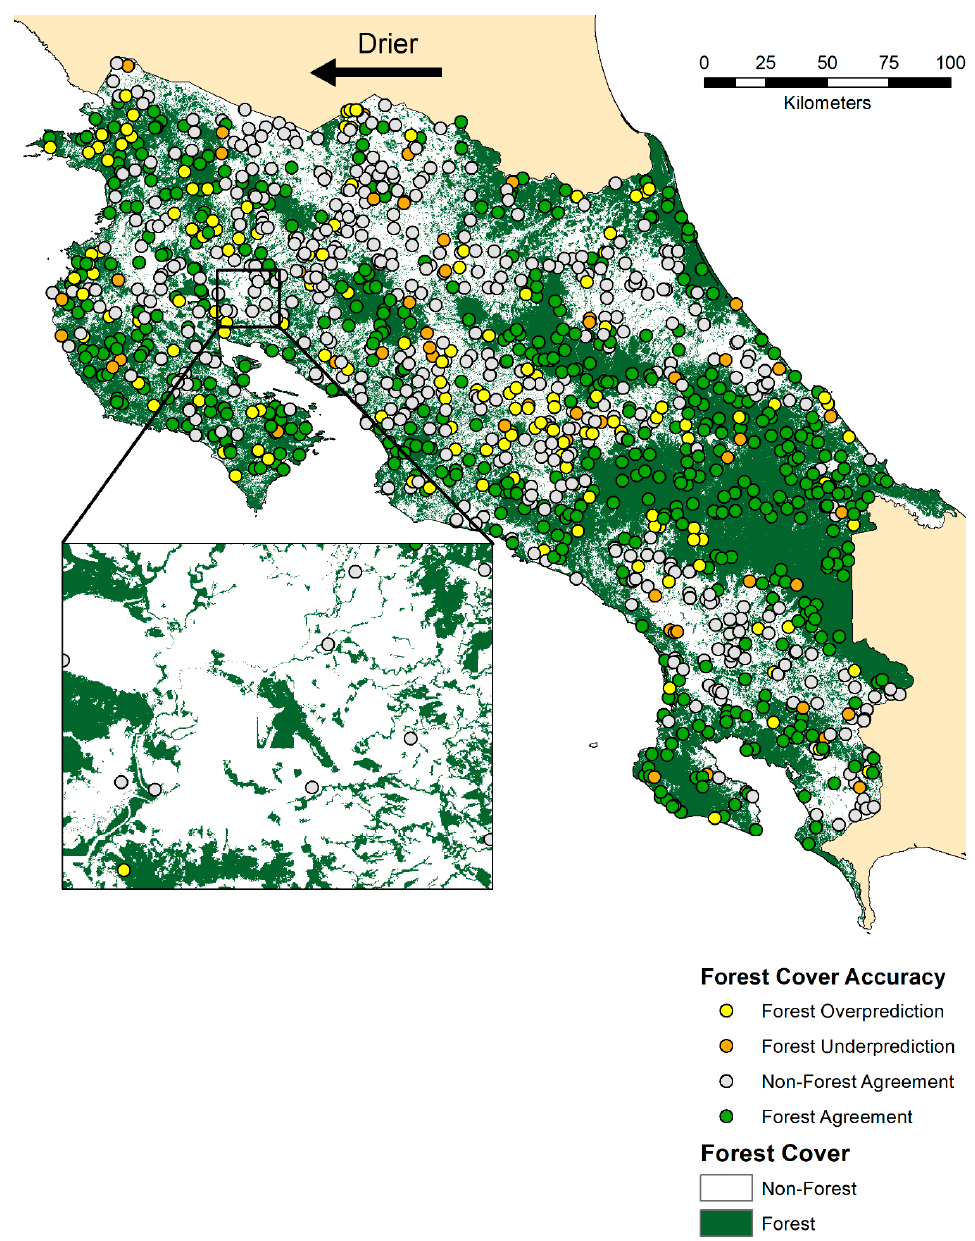
Figure 5. Global Crop Land forest cover, showing the spatial distribution of forest cover errors when compared to reference data in Costa Rica ( n = 1154). Because the GCL forest cover is a binary forest/non-forest classification, an 89% tree cover threshold was applied to the reference dataset. The colored points reflect the confusion matrix errors, visualized on the map. The Landa regional map had the lowest overall accuracy (79.3 +/ − 2.4%; Tables 3, A2) at the 89% threshold, although it was comparable to or slightly better than the GFC product across a wide range